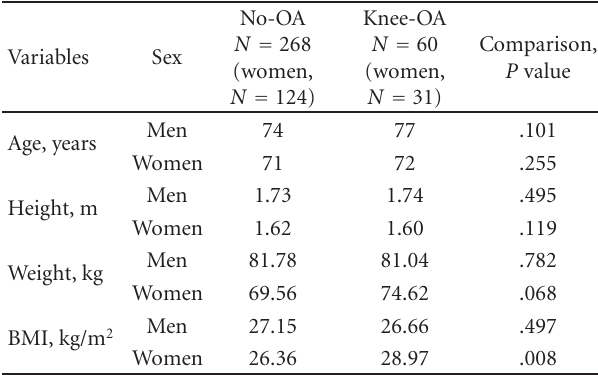
Table 1: Participants